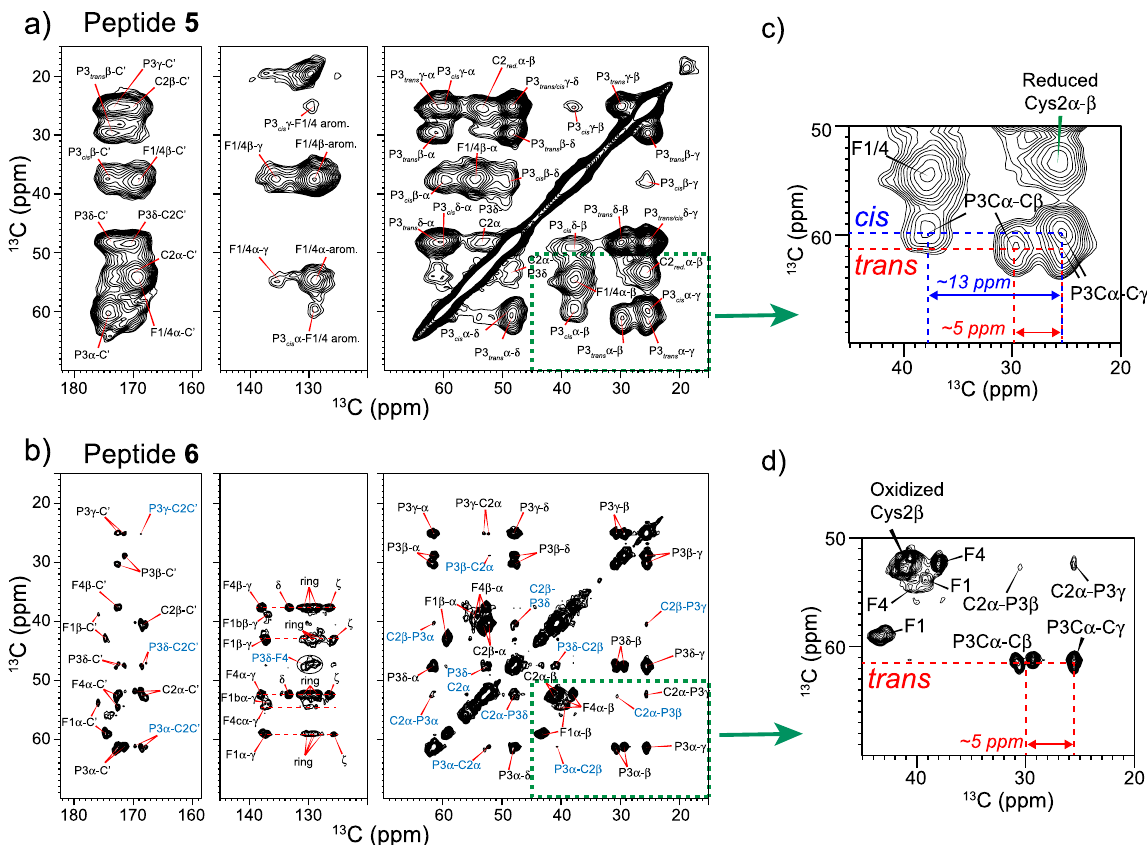
Figure 4. 2D 13 C- 13 C correlation spectra of the ( a ) unreacted π -clamp peptide 5 and ( b ) PFA-tagged peptide 6 . The spectra were acquired at 298 K. ( c , d ) Enlarged regions showing Pro3 and Cys2 cross peaks. The Cys2 C β chemical shift indicates that Cys2 is in a reduced state (~25 ppm) in peptide 5 ( c ), and in an oxidized state (~40 ppm) in the PFA-tagged peptide 6 ( d ). The chemical shift difference between Pro C β and C γ indicates the isomer state. The Pro intensity in ( c ) indicates an about 1:1 ratio between the cis and trans isomers in the unreacted peptide 5 . The Pro signal in ( d ) shows only the trans Pro conformation is adopted in PFA-tagged peptide 6